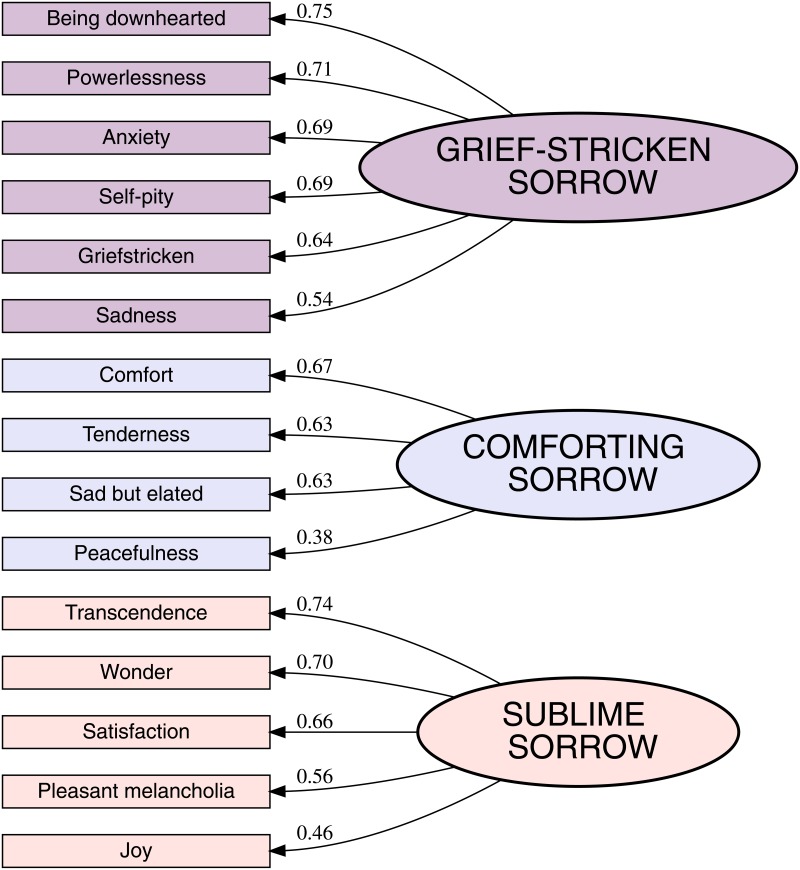
Rotated factors loadings for the three latent affect factors.